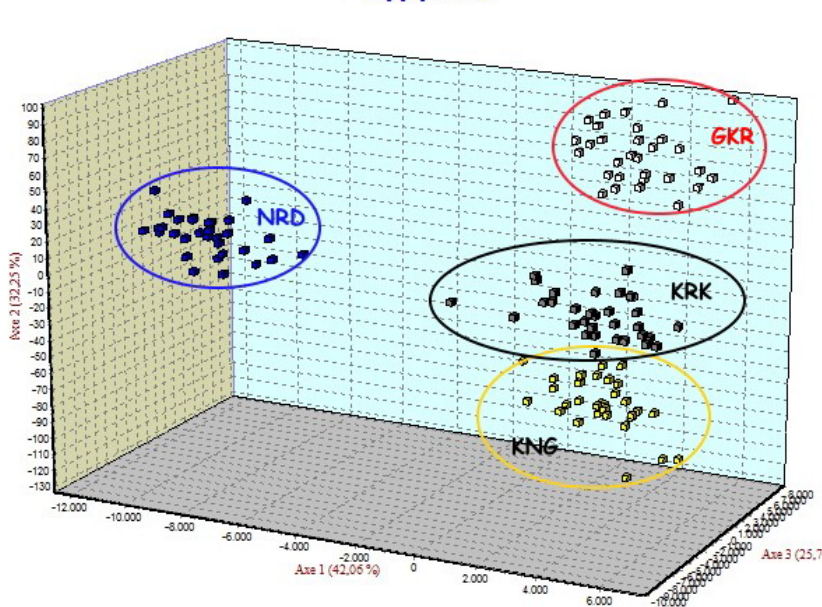
Figure 3. Factorial correspondence analysis among four sheep breeds. GKR: Güney Karaman; NRD: Norduz; KNG: Kangal; KRK: Karakas.